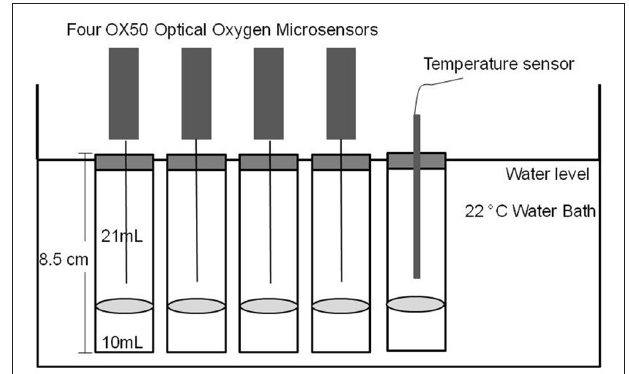
FIGURE 1 | Setup of the optical oxygen microsensors in the aquatic